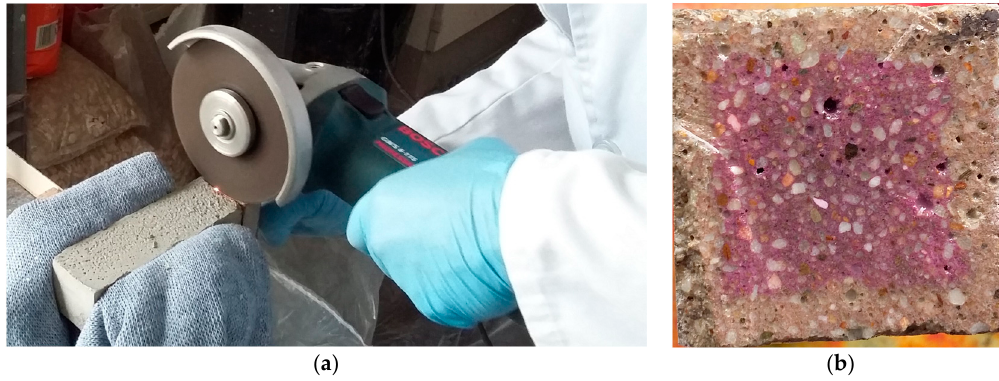
Figure 1. Carbonation depth measurement: ( a ) Cutting; ( b ) phenolphthalein pH-indicator test.